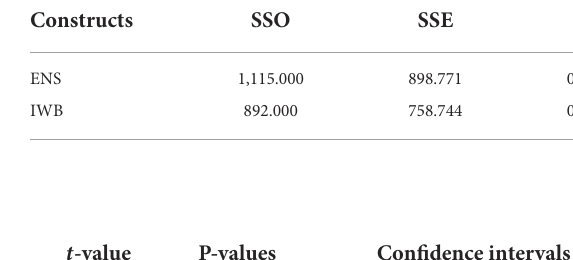
TABLE 4 Construct cross-validated redundancy.